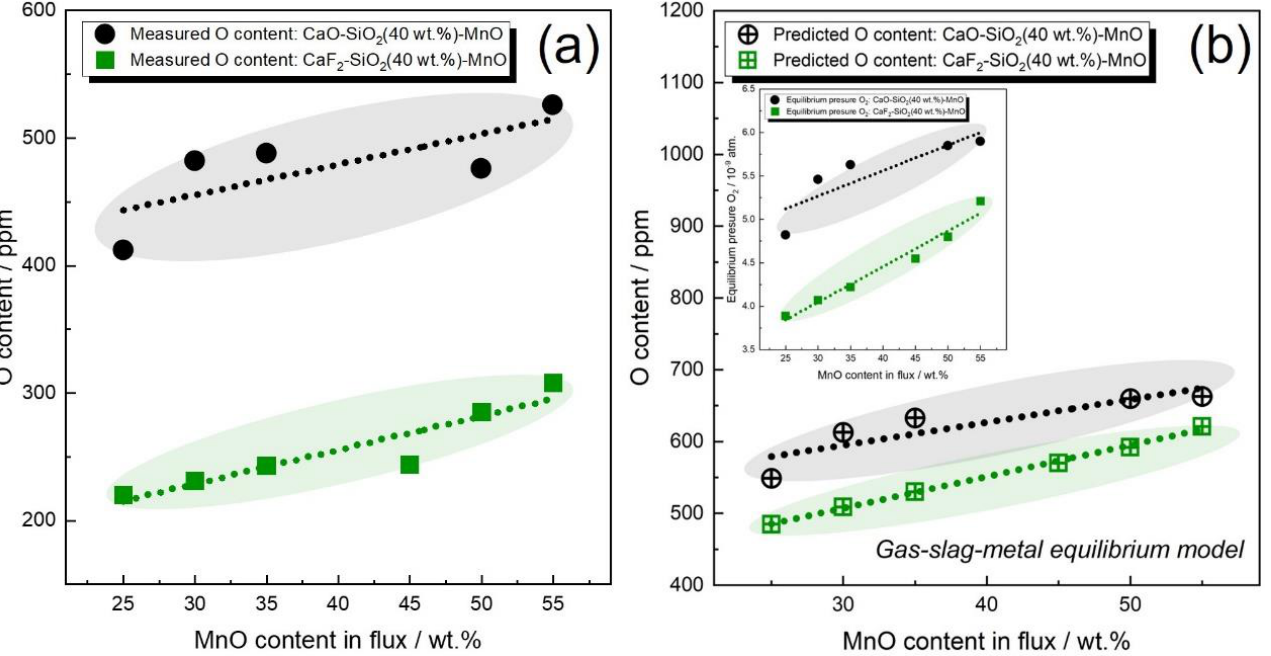
Figure 7. WM O content and equilibrium p O2 as a function of MnO content in flux.